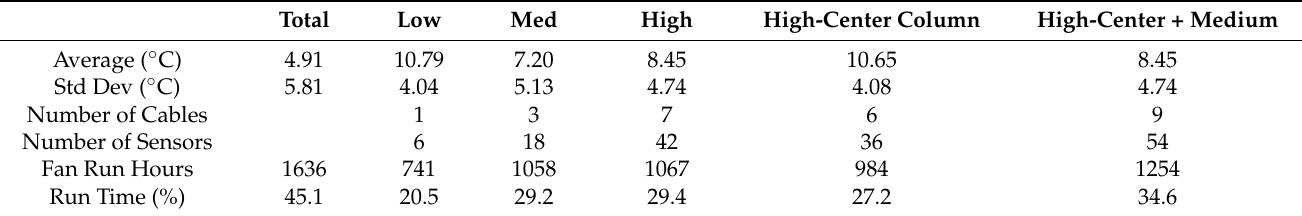
Table 2. The average temperatures and standard deviations, aeration fan run hours, and percent of fan run time through the end of February, calculated for the entire grain mass for each of the three cable configurations defined in Figure 2, as well as the high sensor distribution without the center cable, and that distribution plus the medium, versus the average temperature calculated for the numerical solution (Total) for a one-year controlled aeration simulation of 1346 MT of maize beginning 1 October, 2014. The fan was turned on whenever ambient air was cooler than the average temperature reported by the sensors and the average was above 0 ◦